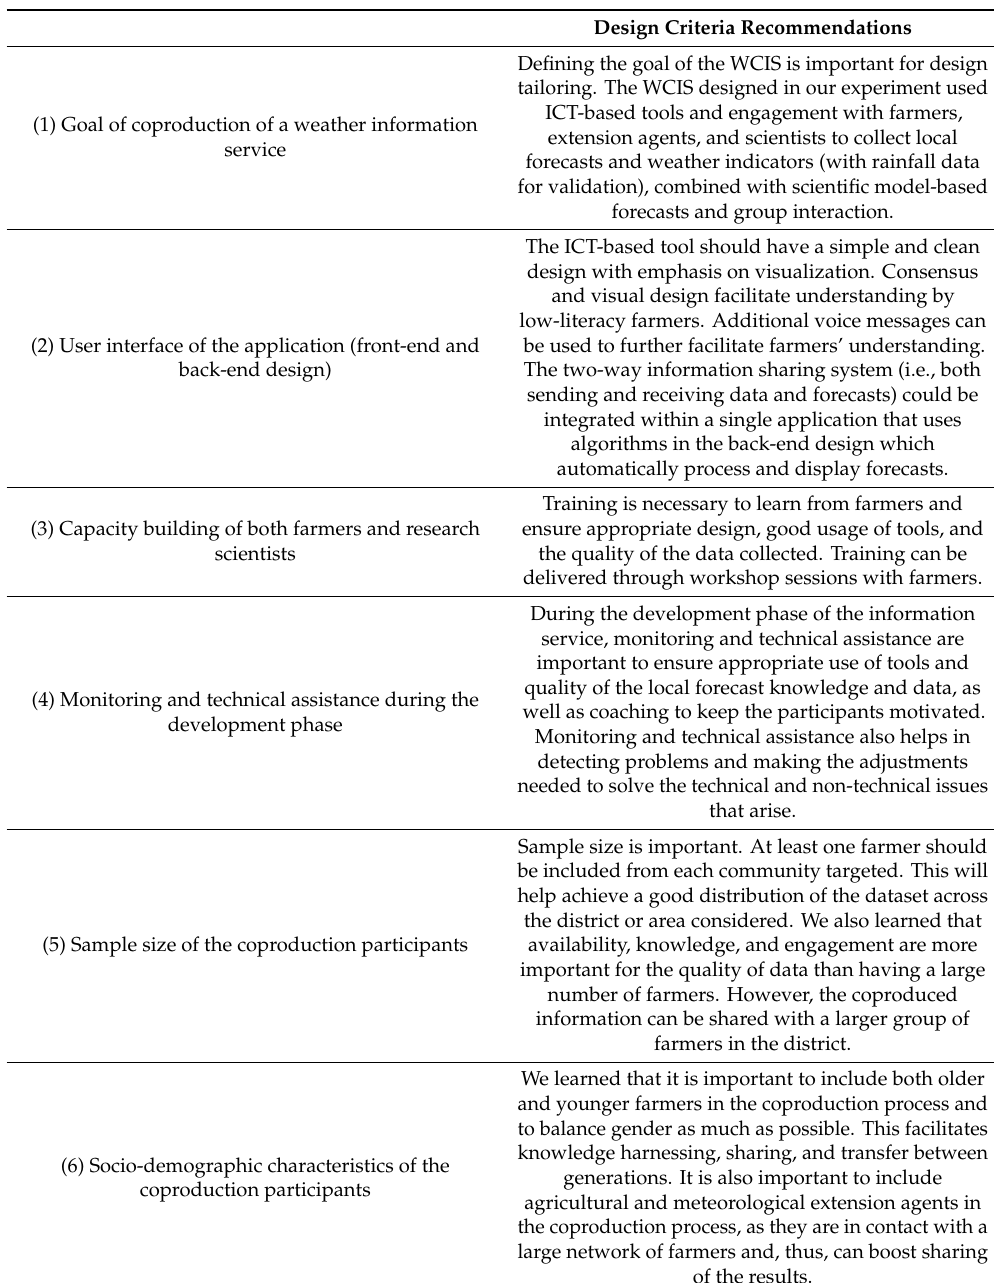
Table 5. Recommended design criteria or principles (development phase) for creating an e ff ective weather and climate information system (WCIS) with and for smallholder farmers, combining local and scientific-based forecasting